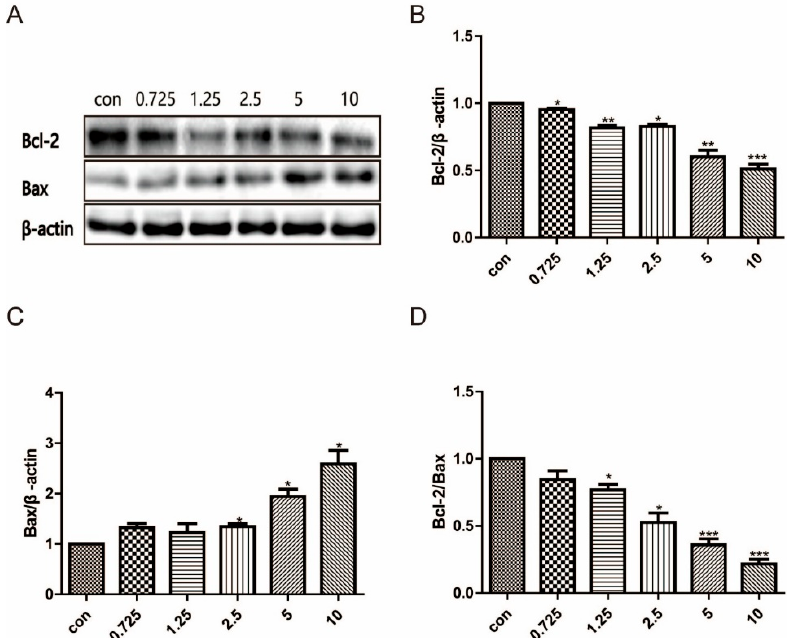
Figure 4. A549 cells were treated with compound 15 (0, 0.725, 1.25, 2.5, 5, 10 µ M) for 72 h. Protein expression levels of Bcl-2 and Bax were measured using western blot analysis. ( A ) Representative western blot images are shown. ( B ) Grayscale value analysis of Bcl-2, ( C ) Bax and ( D ) Bcl-2 / Bax ratio. Data are expressed as means standard deviation from three independent experiments. * p < 0.05, ** p < 0.01 compared with the control group.